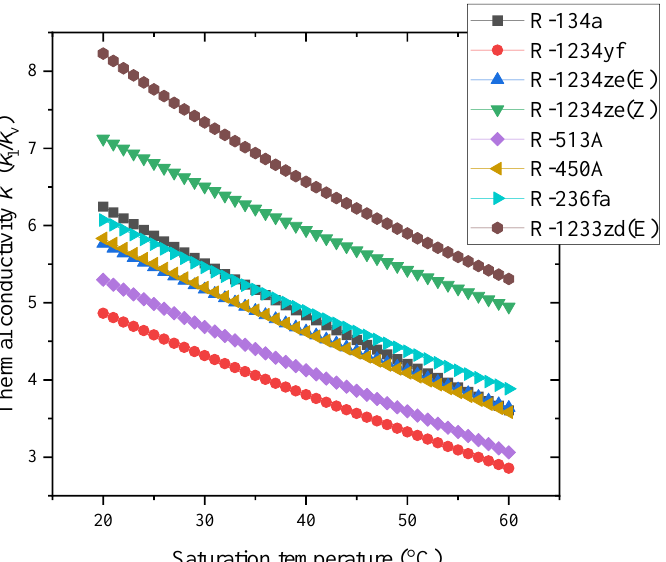
Figure 22. Saturation temperature versus surface tension of alternatives to R-134a [1].